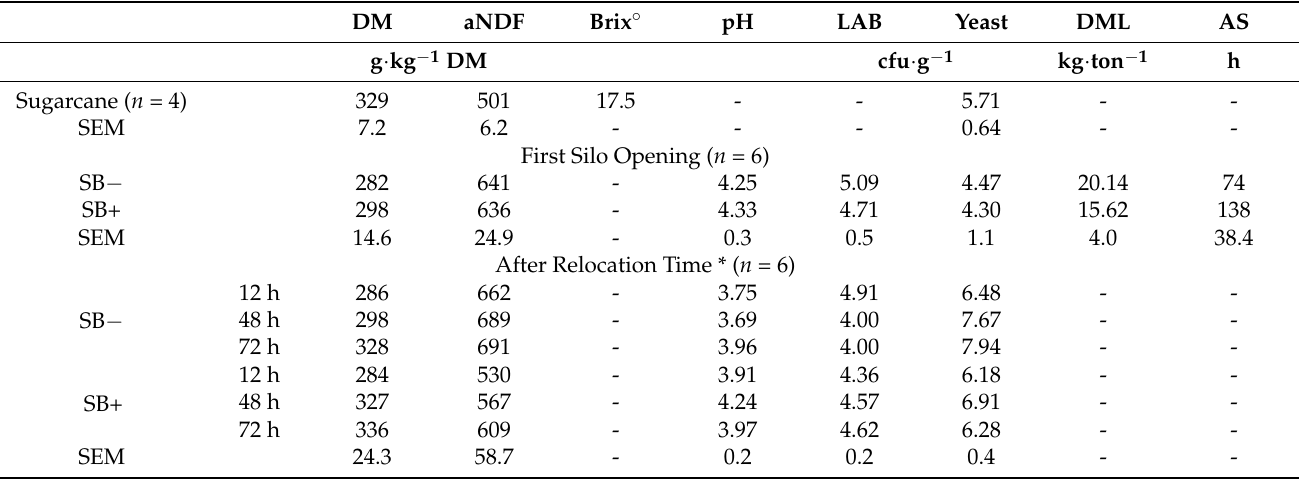
Table 1. The characterization of the sugarcane samples and silage at the first opening and after exposure during relocation without (SB − ) or with sodium benzoate (SB+; 2 g · kg − 1 on a fresh matter basis). DM aNDF Brix ◦